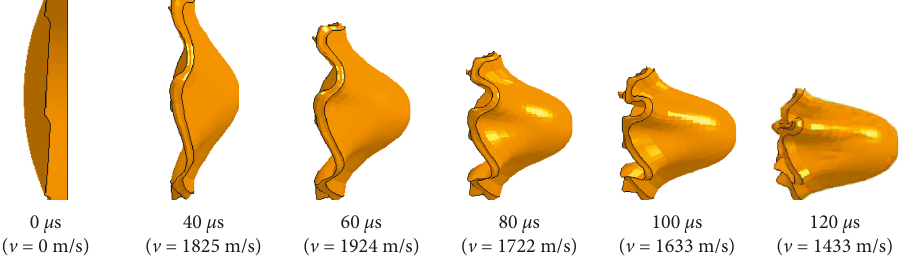
Figure 13: EFP formation process for a step-shaped liner.